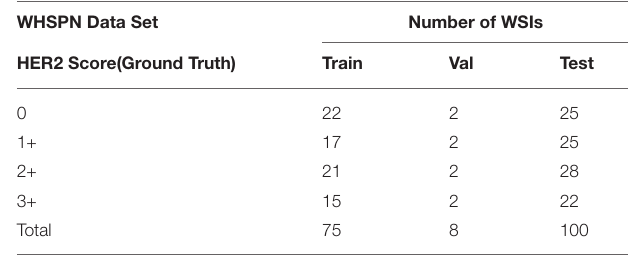
TABLE 2 | Demographics of the dataset used for Tile-level classification network (TLCN). TLCN Data Set